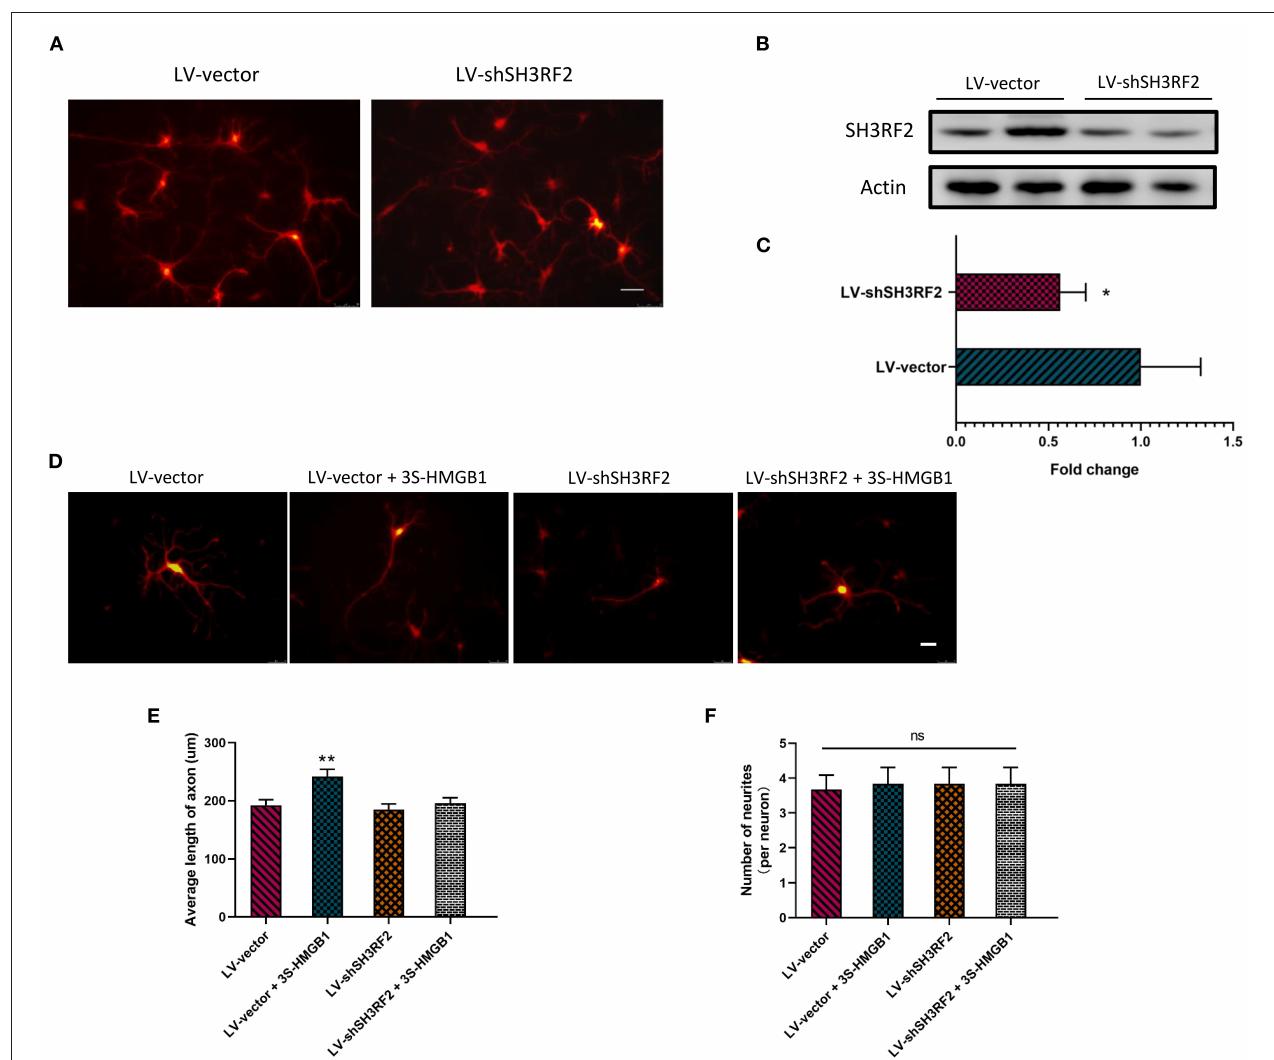
FIGURE 4 | Nonoxid-HMGB1 promotes axon growth by SH3RF2. (A) Representative images of neurons after transfection for 72h. Scale bars, 50 um. (B,C) Assessment of silencing efficiency by relative quantification of SH3RF2. (D,E) Representative electron microscopy images show that nonoxid-HMGB1 promotes axon growth in control (LV-vector) primary neurons, and it does not cause marked changes of axon growth in shSH3RF2 primary neurons. Scale bars, 50 um. (F) Treatment with nonoxid-HMGB1 did not alter the neurites number in control (LV-vector) primary neurons and in shSH3RF2 primary neurons. Mean ± SEM, * p < 0.05, ** p < 0.01, ns: no